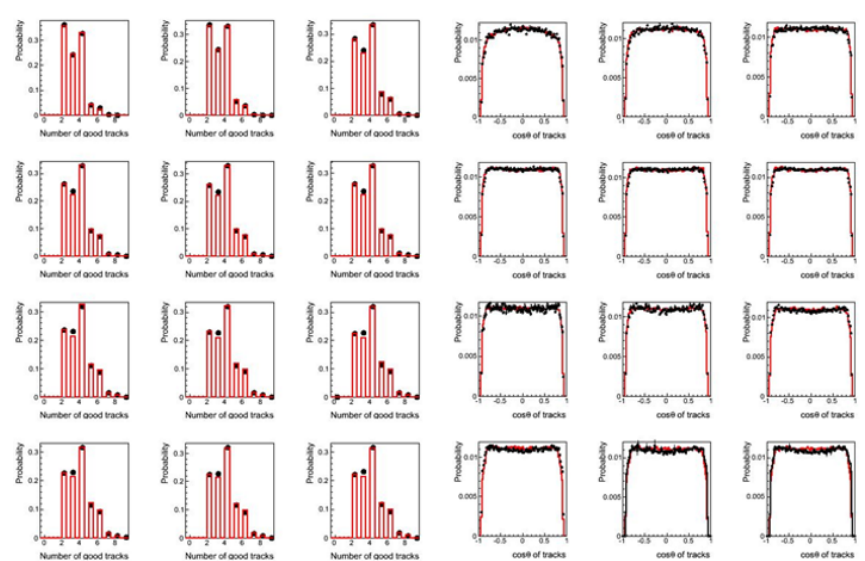
Figure 3. The distributions for multiplicity (left) and cos θ of charged track (right), the black points are distribu- tion of experimental data, where contribution from background events are already subtracted, the red histogram are obtained by LUARLW generator.